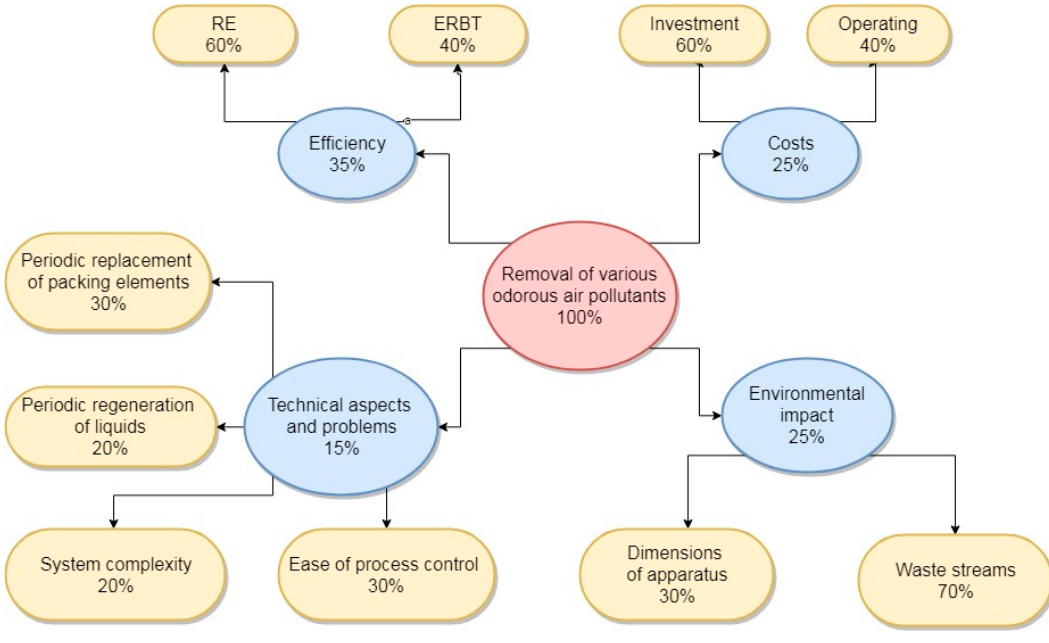
Figure 2. Hierarchy of selected criteria and sub-criteria.